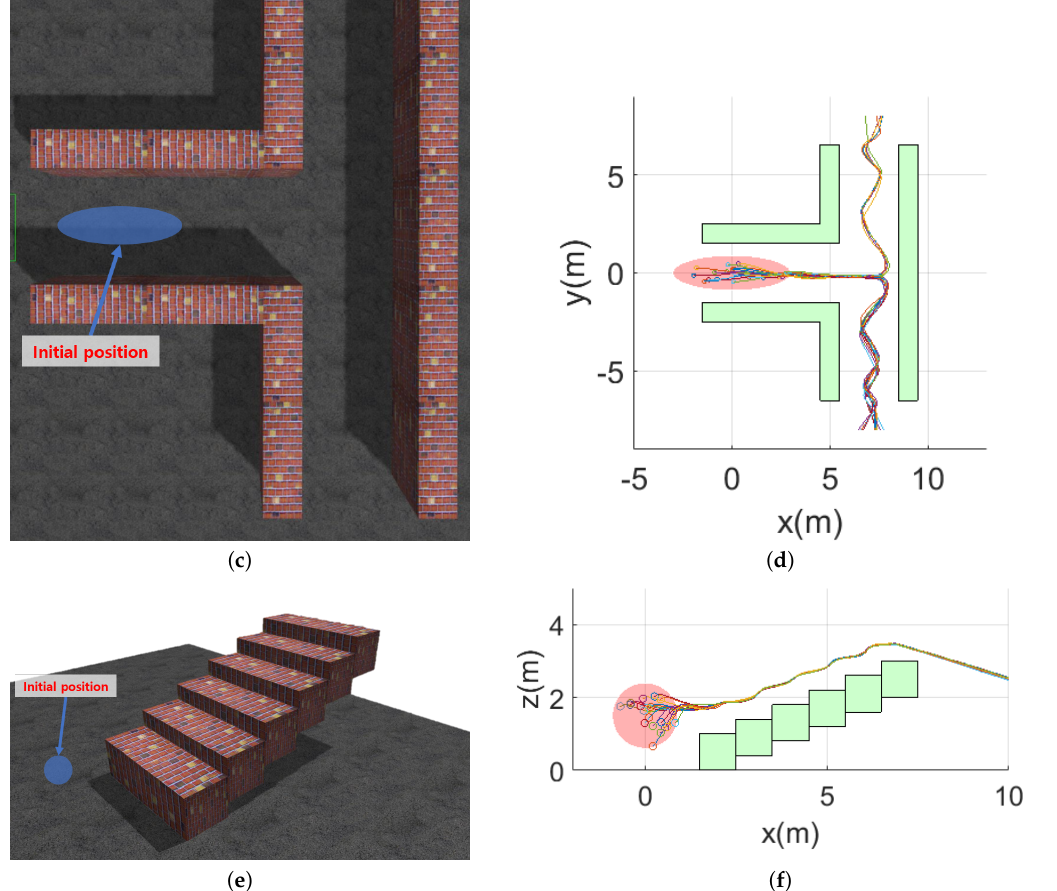
Figure 8. Maps and MAV trajectories for simulations: ( a ) L-shape corner map; ( b ) MAV trajectories at the L-shape corner map; ( c ) T-shape junction map; ( d ) MAV trajectories at the T-shape corner map; ( e ) ramp-shape map; and ( f ) MAV trajectories at the ramp-shape